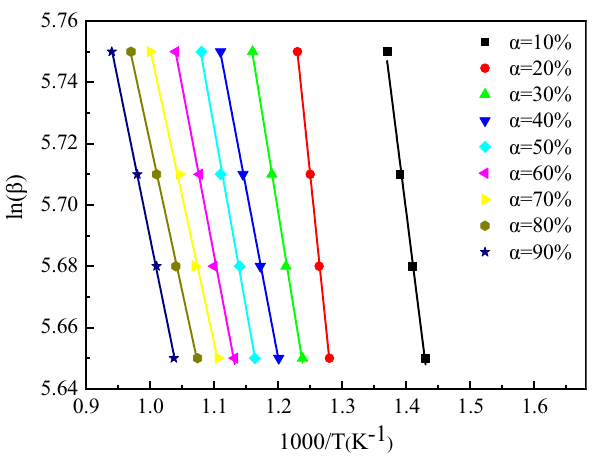
Figure 4: FWO method plots of sample D2 in di ff erent conversion degrees.